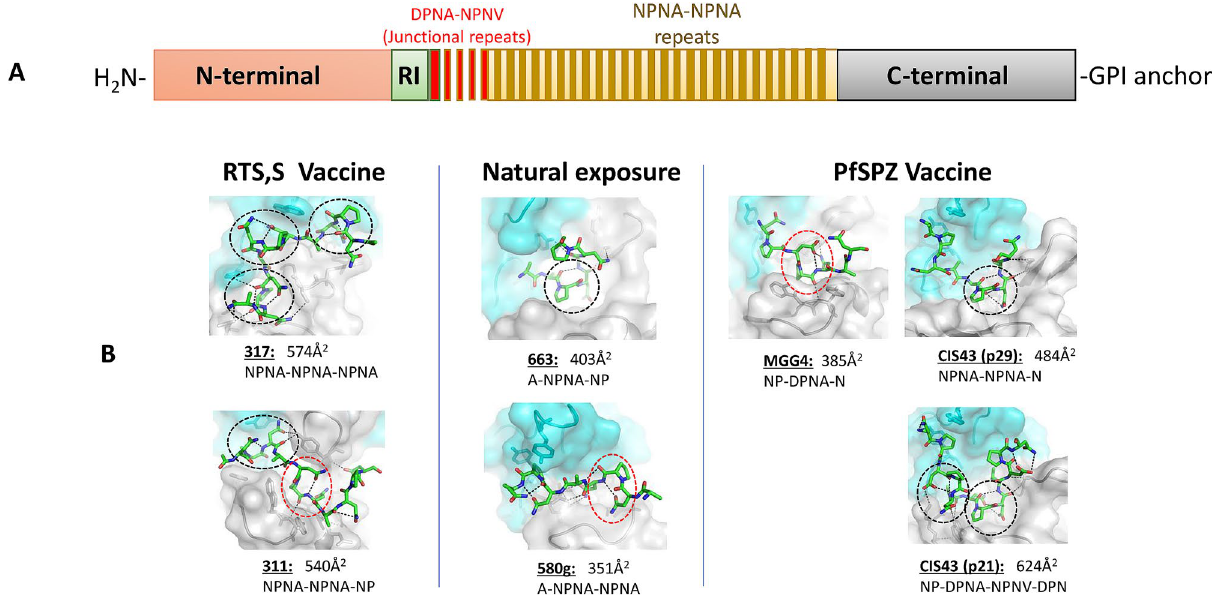
Figure 1. Structural analysis of mAb binding to protective P. falciparum Circumsporozoite protein (CSP) epitopes. ( a ) Schematic representation of full-length CSP (not to scale). ( b ) Antibody paratope structures depicting monoclonal antibody binding to representative repeat or junctional peptides: 311 (PDB code 6AXK), 317 (6AXL) 18 , CIS43 bound to peptide 21 (6B5M) and peptide 29 (6B5O) 12 , germline 580 (6AZM) and 663 (5BK0) 19 , MGG4 (6BQB) 21 . The contact area between the peptides and the complementarity determining regions, or the buried surface area (BSA), shown under each structure were calculated using the AREAIMOL program in the CCP4 software suite 43 . Heavy and light chains are colored blue and light grey, respectively. Peptides are depicted in stick conformations (green carbons). Hydrogen bonds are shown as black dashes. Type I β and 3 10 turns are indicated by black and red circles,